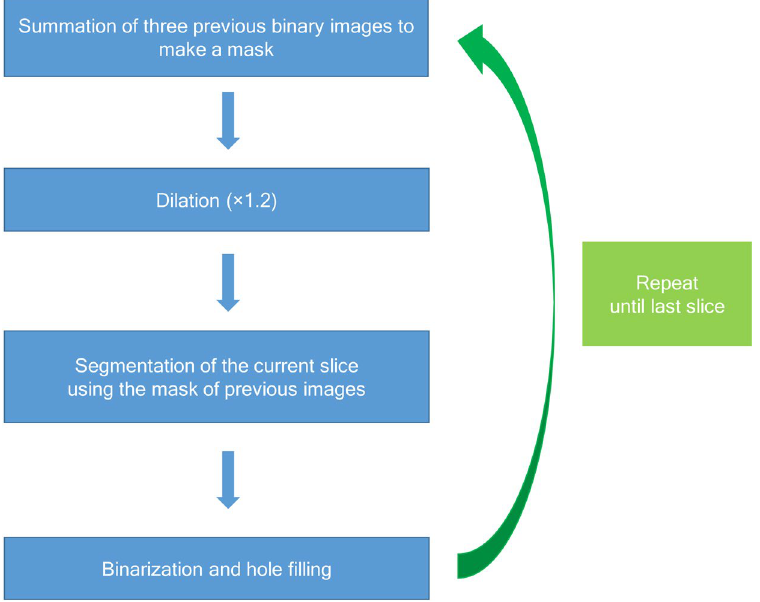
Figure 4. A cumulative binarization algorithm for mandible segmentation. This algorithm summed the 3 previous binarization images to create a mask for the segmentation of the current slice.